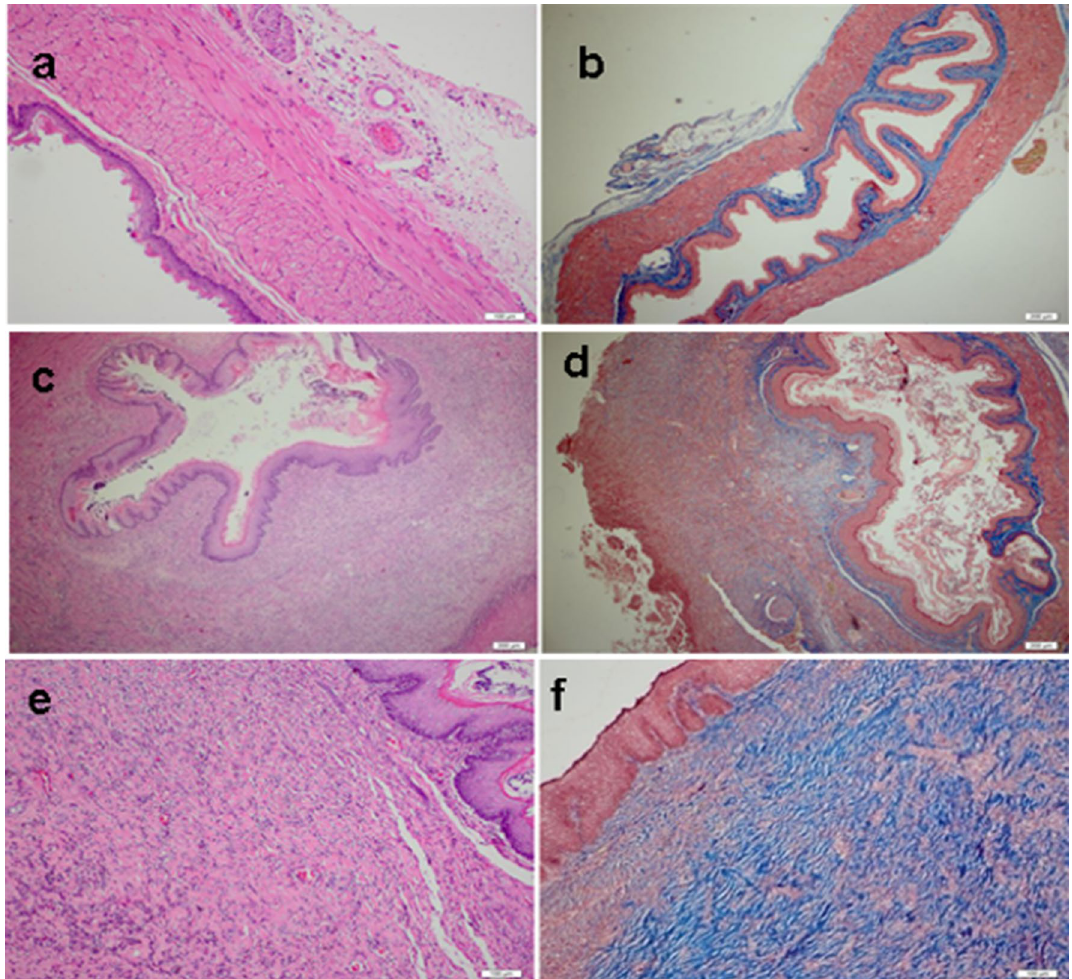
Figure 2. Mean histopathological pictogrammes of the groups studied. ( a , b ) Esophageal mucosa belonging to the control group. ( a ) There is normal archetype preserved esophageal full-thickness mucosa sample containing lamina propria and muscularis propria consisting of compact connective tissue observed under the surface ceratinized squamous epithelium, in the Hematoxylin&Eosin (H&E), × 100). ( b ) There is no collagen increase in the submucosal and muscular layers, in the Mason Trichrome Stain, × 100. ( c , d ) Esophageal mucosa belonging to the groups of sham and FGF(−). For the Groups of Sham and FGF(−) not received FGF, there are noteworthy epithelial degeneration, intense inflammation in the submucosa and muscular layer, and mildly increased collagen, in the Mason Trichrome Stain, × 100 and Hematoxylin&Eosin (H&E), × 100. ( e , f ) Esophageal mucosa belonging to the groups given FGF. ( e ) In the surface epithelium, there is marked regeneration as well as the presence of significantly increased collagen, which is replaced by the submucosal and muscular layer. There is a moderate decrease in the inflammatory cell density observed between the collagen bundles on the 7th day and a significant decrease on the 28th day, in the Hematoxylin&Eosin (H&E), × 100. ( f ) There is significantly increased collagen (blue color) between the submucosal and muscular layers observed, in the Mason Trichrome Stain, × in the anastomosis line, and the submucosal and muscle collagen concentration was higher than control groups. They showed that FGF provides remodeling by increasing fibroblastic proliferation and collagen maturation. They also reported an increase in epithelial healing. They observed that this epithelial cell restitution is highly advantageous in increasing water/airtightness in esophageal wound healing. They also suggested that fibroblast growth factor (FGF) may induce recovery by inducing angiogenesis induction and esophageal anastomosis, but more studies are needed to demonstrate the effect of neovascularization due to immunohistochemistry and capillary density. Although the increased collagen accumulation effect in the anastomosis region was seen to increase the healing effect in the short term, they could not give any results on whether it could lead to potential stenosis in the long term. In our study, it was seen that until the 28th day when the rats were sacrified, no feeding difficulties were observed, and also no fibrosis was detected in the immunopathological examination. However, since our